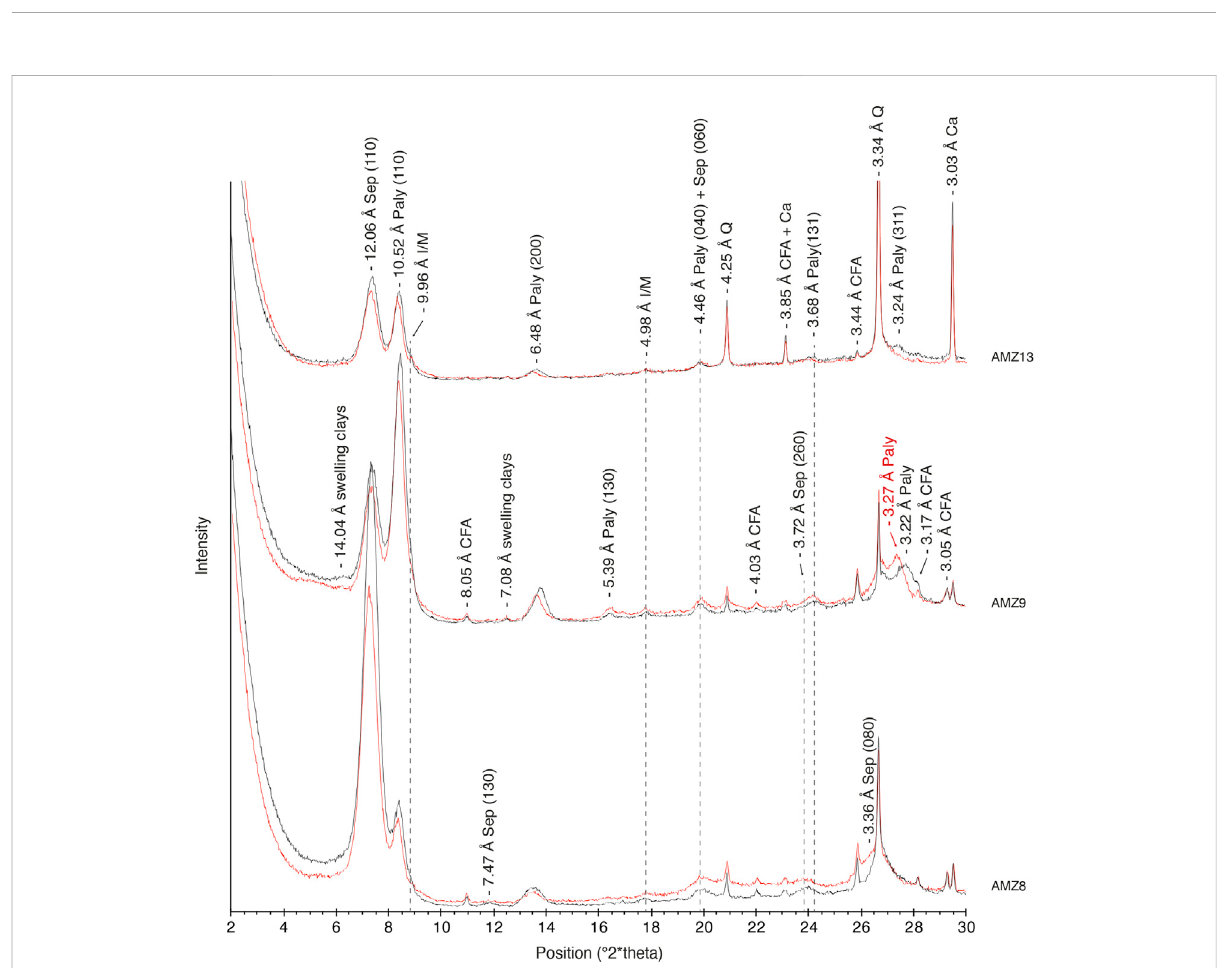
FIGURE 5 XRD patterns of the < 2 µm clay fraction of Amizmiz phosphorites. Oriented preparations after airdrying (black lines) and glycolation (red lines). Sepiolite (Sep); Palygorskite (Paly) illite/mica (I/M); quartz (Q); carbonate fl uorapatite (CFA); calcite